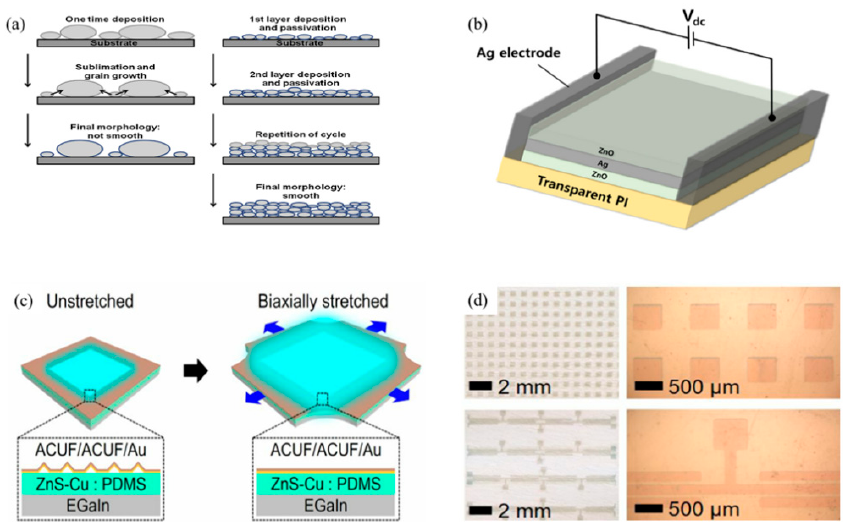
Figure 2. ( a ) Schematic sketch of metal film deposition (conventional deposition and new multilayer deposition strategy) [55]; ( b ) schematic structure of the ZnO/Ag/ZnO transparent heater fabricated on top of a transparent PI substrate [50]; ( c ) schematic architecture of a stretchable ACEL device before and after stretching; ( d ) photographs and OM images of patterned ACUF/anisotropic conductive ultrathin film (ACUF)/Au electrodes and their interconnection